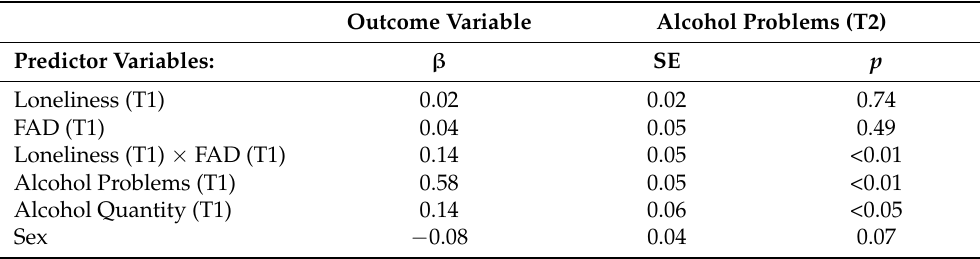
Table 3. Summary of main and moderating effects of loneliness (T1) and FAD (T1) on alcohol-related problems (T2) while adjusting for the effects of alcohol problems (T1), quantity (T1), and sex. Outcome Variable Alcohol Problems (T2)